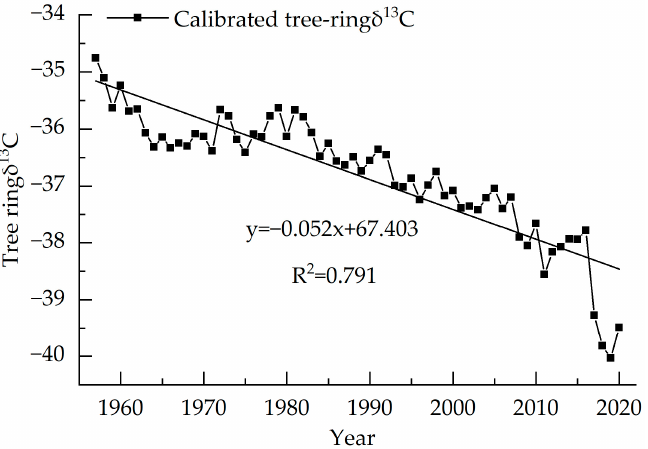
Figure 5. Calibrated tree ring δ 13 C of Picea meyeri chronologies on Luya mountain.